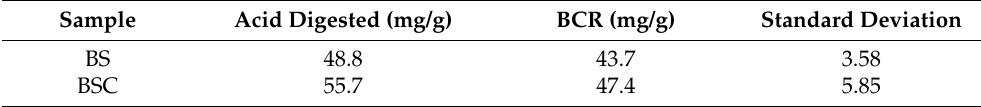
Table 5. Comparison of total metal content in BS and BSC